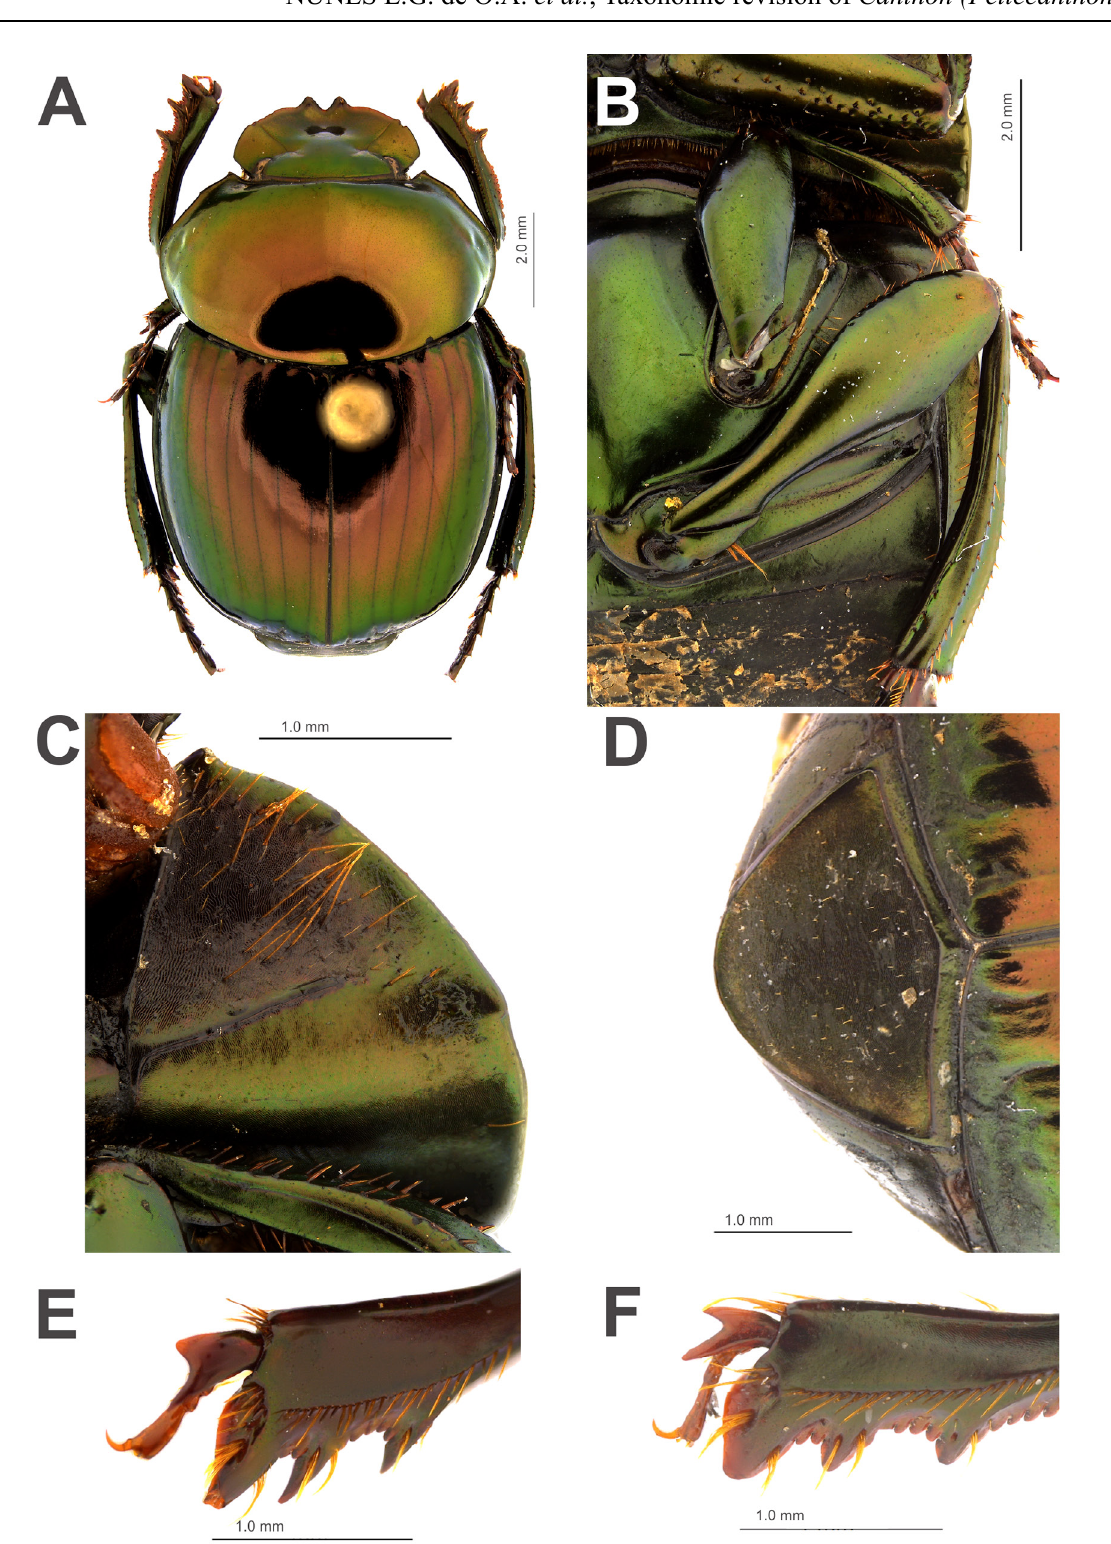
Fig. 7. Canthon ( Peltecanthon ) terciae sp. nov., paratype, ♂, Rio Grande do Norte, Baia Formosa, Mata Estrela (CEMT). A . Dorsal habitus. B . Ventral surface of meso- and metafemora. C . Transverse carina in the hypomeron. D . Carina in the margin between pygidium and propygidium. E . Male protibial spur. F . Paratype, ♀, Rio Grande do Norte, Baia Formosa, Mata Estrela (CEMT), protibial